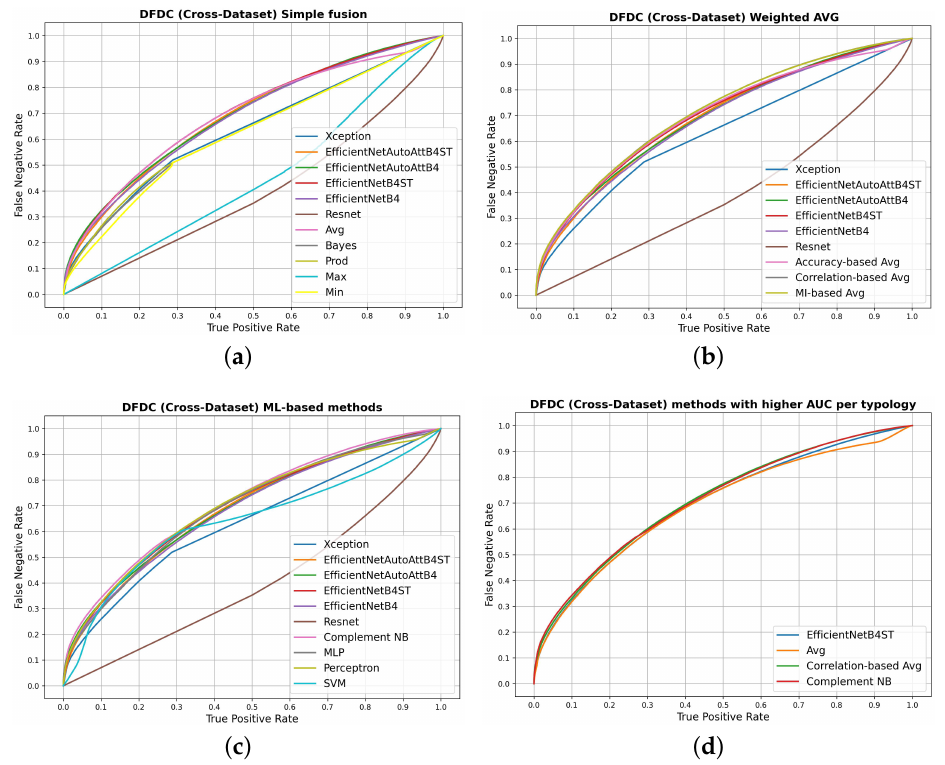
Figure 6. ROC curves on the DFDC dataset comparing the single deepfake detectors with their fusion through non-parametric approaches ( a ), the approaches based on weighted averages ( b ), the ones based on machine-learning models ( c ) and comparing the most performing methods of each category with respect to the obtained AUC ( d